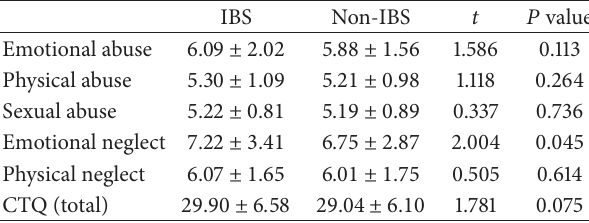
Table 4: The CTQ scores between IBS and